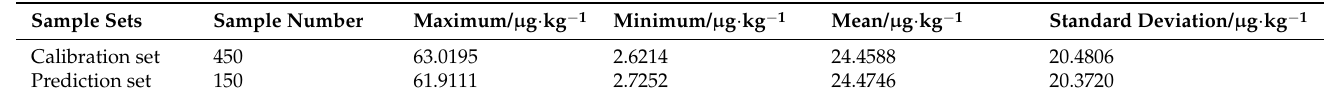
Table 1. Statistical results of the AFB 1 value of peanut oil samples in calibration set and the predic- tion set.